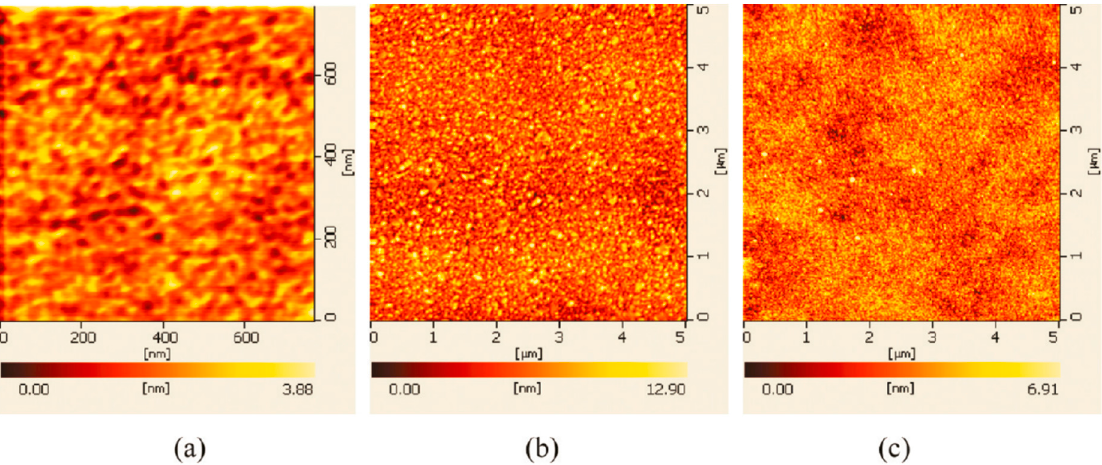
Figure 2. Atomic force microscopy (AFM) images of the ( a ) Au, ( b ) Ag, and ( c ) Cu films [29].